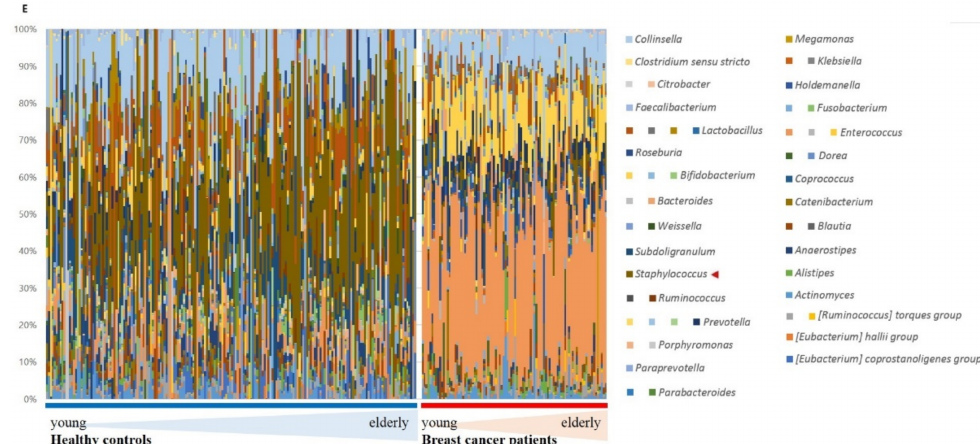
Figure 1. Microbiome analysis of blood samples from patients with breast cancer and healthy controls. ( A ) Microbiome differences between patients with breast cancer and healthy controls at the genus level indicated by a histogram. The red arrowhead indicates Staphylococcus sp. ( B ) Heatmap of microbiome differences between patients with breast cancer and healthy controls. The red arrowhead points to Staphylococcus sp. ( C ) Alpha diversity analyzed through the Chao1 index between the breast cancer and healthy control groups. The red and blue lines represent the breast cancer group and the healthy control group, respectively. ( D ) Beta diversity analyzed through the principal component coordinate analysis (PCoA) in patients with breast cancer and healthy controls. PC1, principal component 1; PC2, principal component 2; red dot, breast cancer patients; blue dot, healthy controls. ( E ) Association of the blood microbiome with estrogen metabolism. The bar chart depicts the genus − level percentages of the microbiome in healthy controls and breast cancer patients. Data were averaged to select for bacteria abundant in more than 0.1% of the microbiota. Bacteria listed in Table 1 were selected, and only those with a p − value of 0.01 or less were selected for analyses.